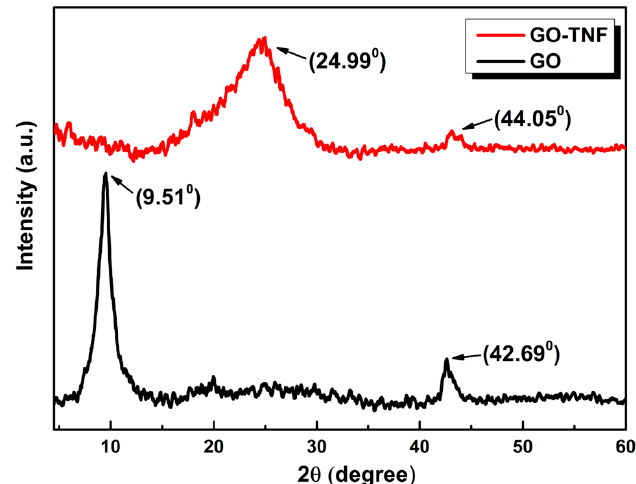
Figure 7. X-ray di ff raction patterns of GO (black) and GO-TNF (red). Figure 7. X-ray diffraction patterns of GO (black) and GO-TNF (red). Figure 7. X-ray diffraction patterns of GO (black) and GO-TNF (red).